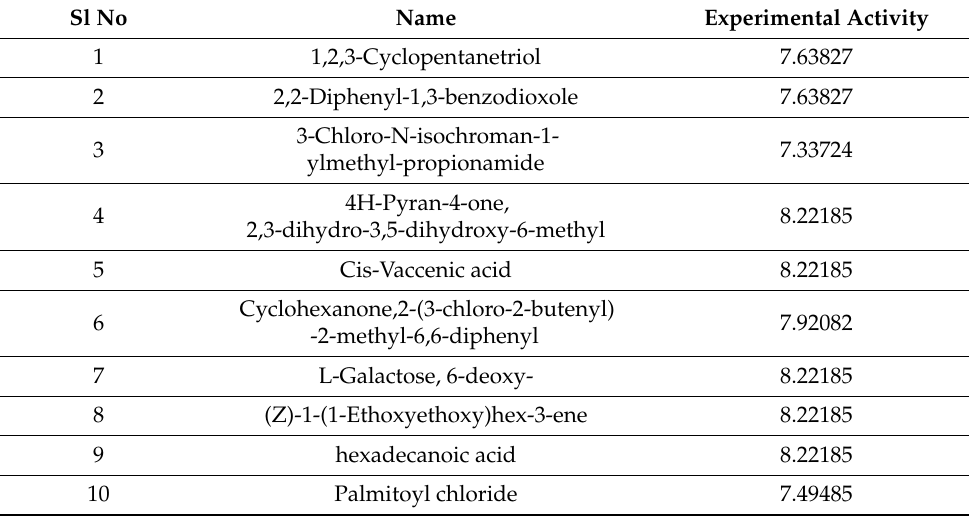
Table 9. Experimental values for the selected compounds.